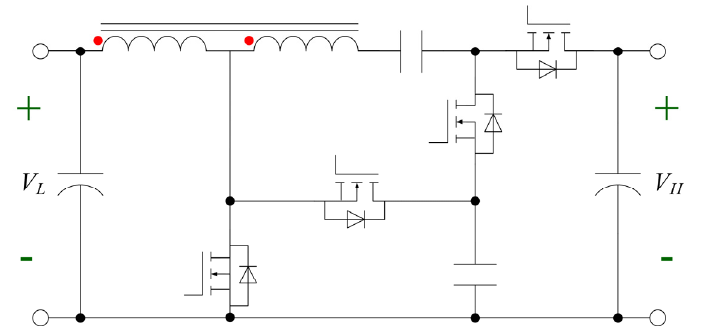
Figure 3. Transformer-based bidirectional DC/DC